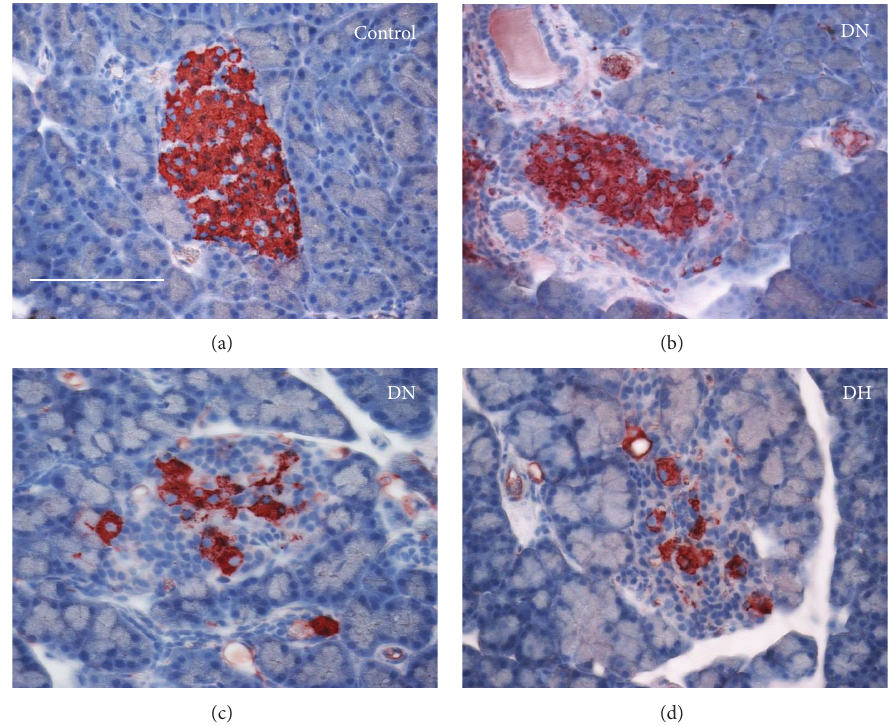
Figure 9: Lymphocyte infiltration in STZ-treated rats. DA rat pancreas was labeled with insulin antibody and with hematoxylin to reveal nuclear staining. (a) Insulin positive islets showed even staining in control rats. Scale bar = 100 𝜇 m for all images. (b) Diabetic normoglycemic (DN) rats showed weak insulin staining in the islet core with atrophied 𝛽 -cells. (c) There were also islets with scattered hypertrophied 𝛽 -cells in the DN group. (d) Diabetic hyperglycemic rats showed few hypertrophied 𝛽